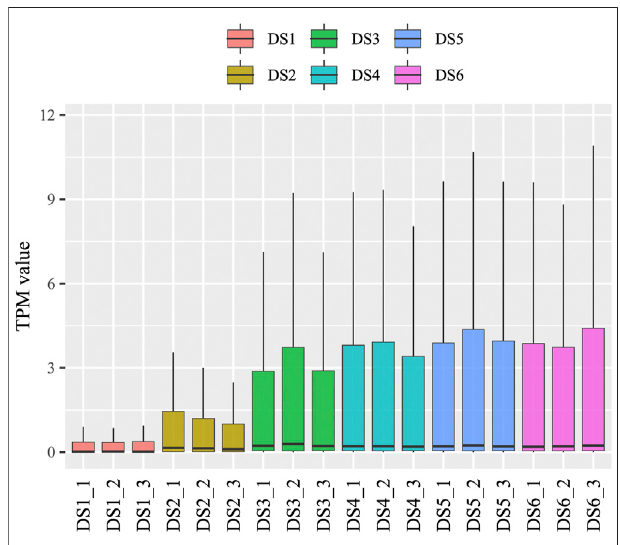
FIGURE 1 | A boxplot of miRNA expression for each